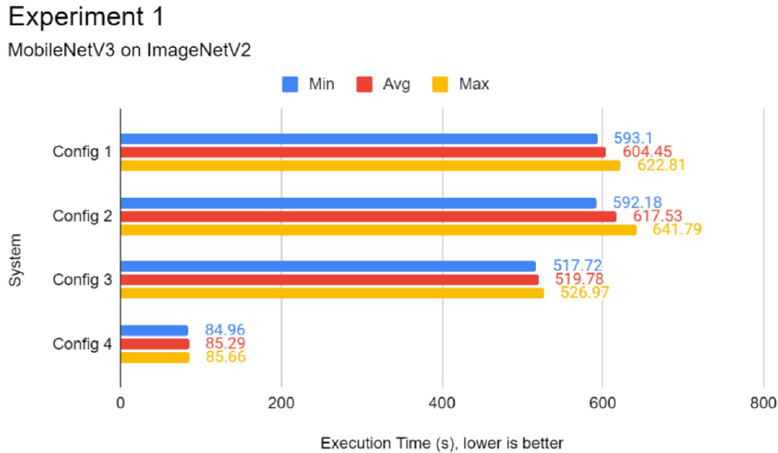
Figure A3. Bar chart execution time results for all systems running MobileNetV3 on ImageNetV2 in Experiment 1.